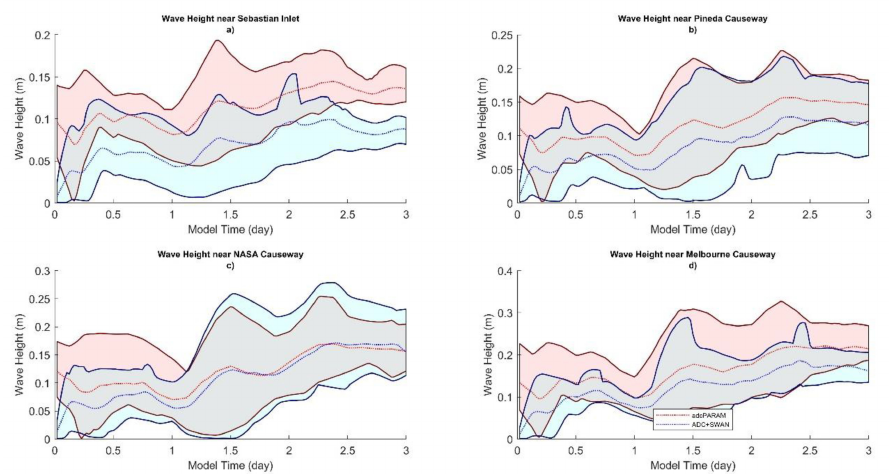
Figure 13. Time series plots of ADCparam and ADCIRC + SWAN ensemble ranges for wave height (meters) near ( a ) Sebastian Inlet, ( b ) Pineda Causeway, ( c ) NASA Causeway, and ( d ) Melbourne Causeway. Each of these locations was selected based on location in the domain and associated fetch (station locations are specified in Figure 8). Dotted lines represent the average solution across the full ensemble, while upper and lower bounds of shaded areas represent the maximum and minimum values of the whole